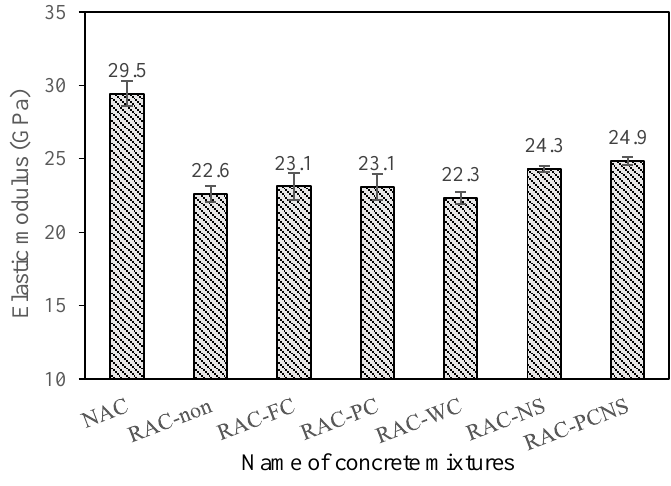
Figure 7. Elastic modulus of hardened concretes.